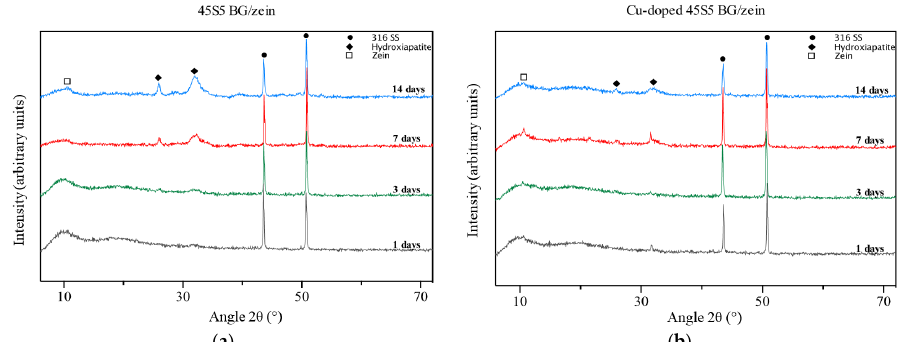
Figure 4. XRD results on coatings soaked in SBF for different immersion times, from 1 to 14 days: ( a ) 45S5 BG/zein coatings; ( b ) copper ‐ doped 45S5 BG/zein coatings.